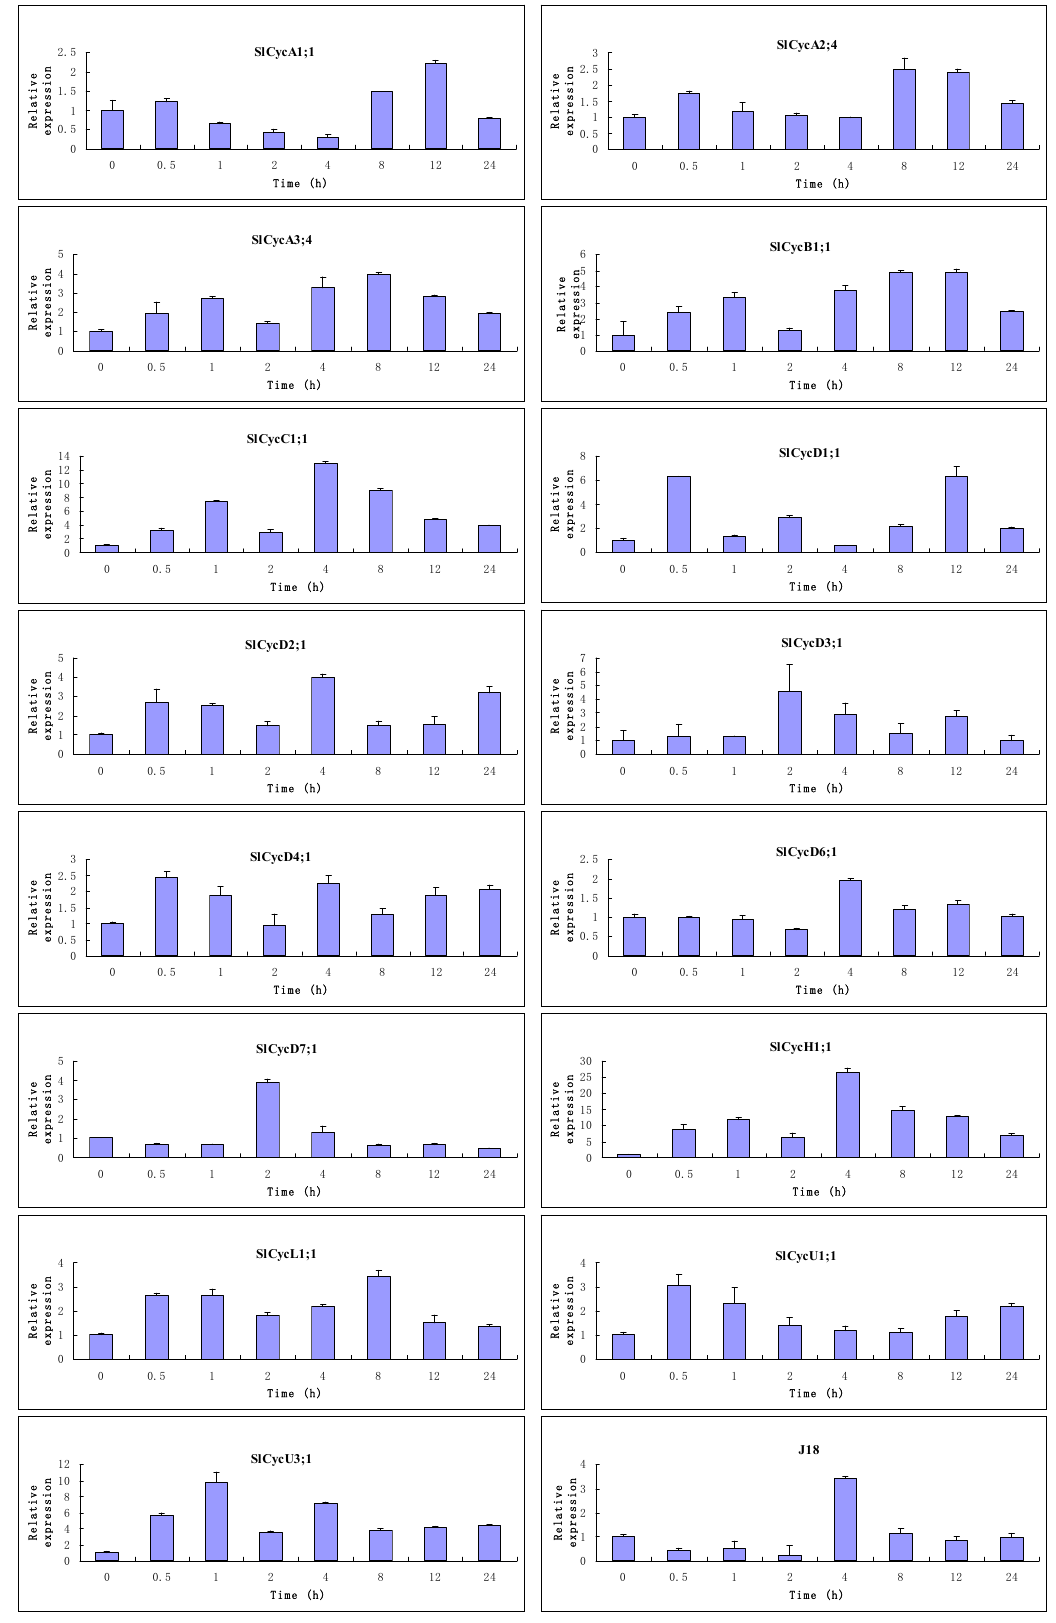
Figure 8. Expression profiles of the tomato cyclin genes after exogenous GA treatment. The relative transcript levels of these genes were analyzed over a 24 h period after 100 μ M GA